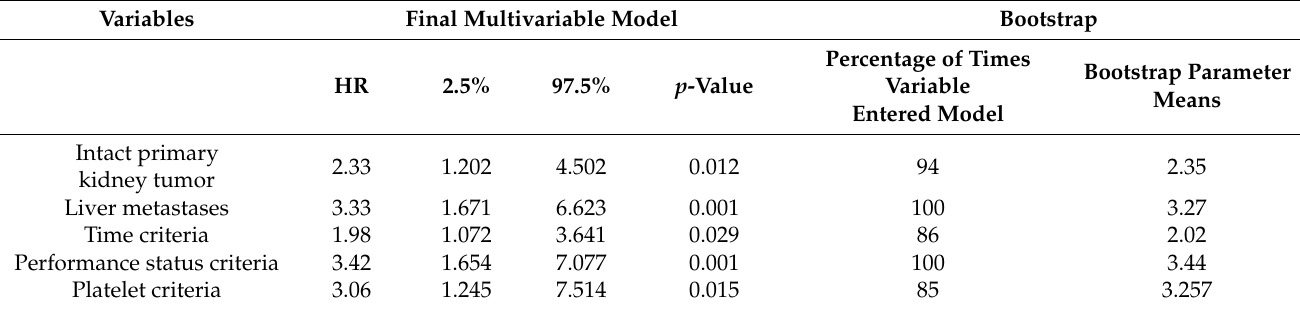
Table 2. Final multivariable model coefficients and bootstrap